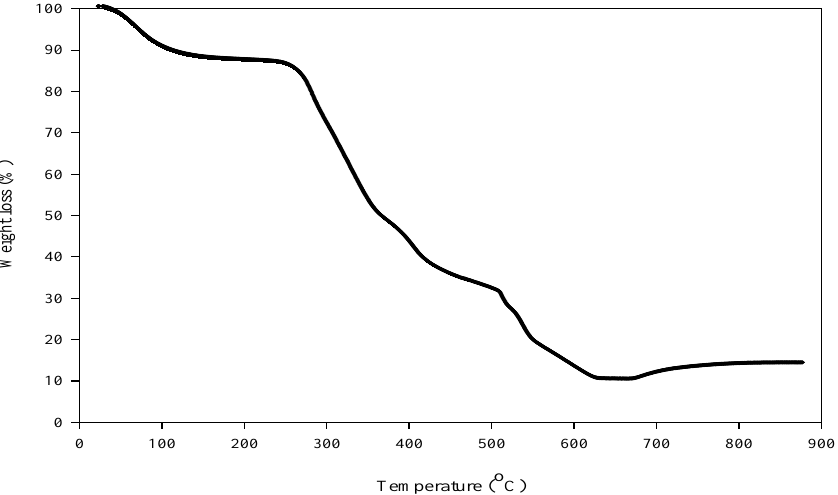
Figure 8. Thermogravimetric analyzer (TGA) thermogram obtained under O 2 atmosphere at 20 °C/min scanning rate for PVP/Ni acetate nanofibers.